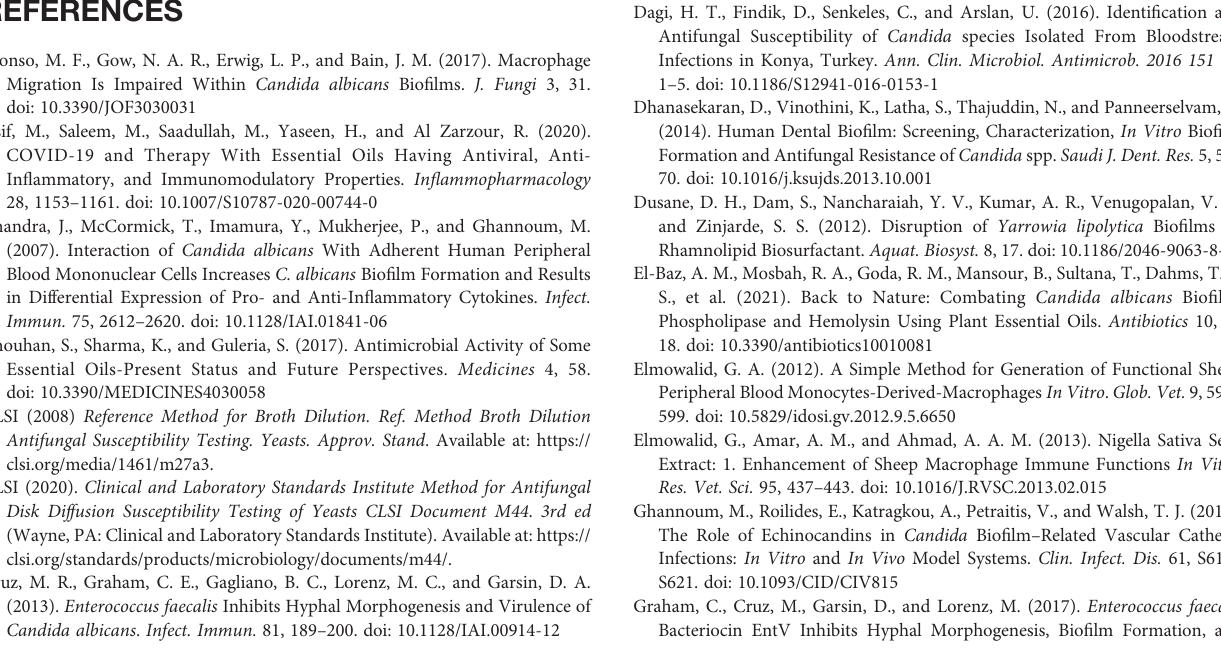
Supplementary Figure 1 | Time-lapse microscopy of C. albicans bio fi lm formation. At 2-h initial adherence of yeast cells followed by germination and micro- colony formation (4 h), fi lamentation and monolayer development (6 h), proliferation (18 h), and maturation (24 – 48 h); mature bio fi lm becomes thick with extracellular polysaccharide layer in which blastoconidia and pseudohyphae are